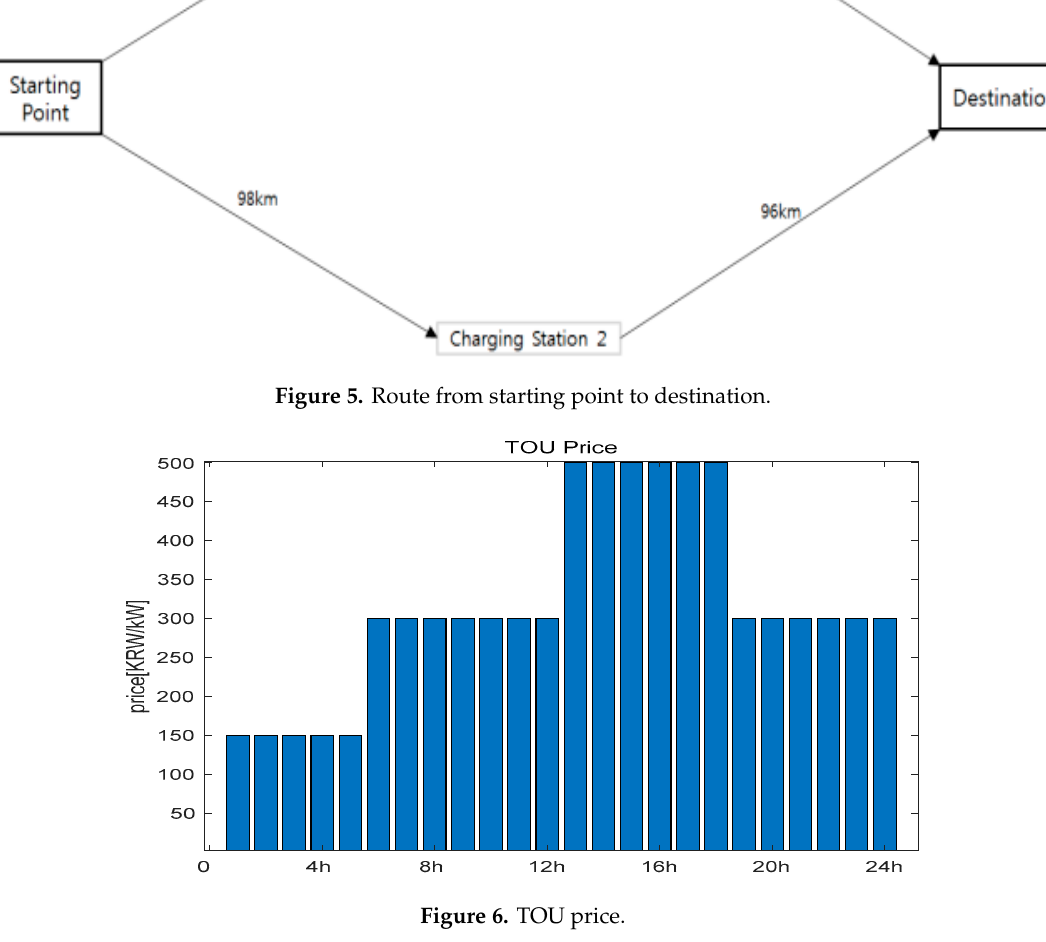
Figure 6. TOU Figure 6. TOU price Figure 6. TOU price